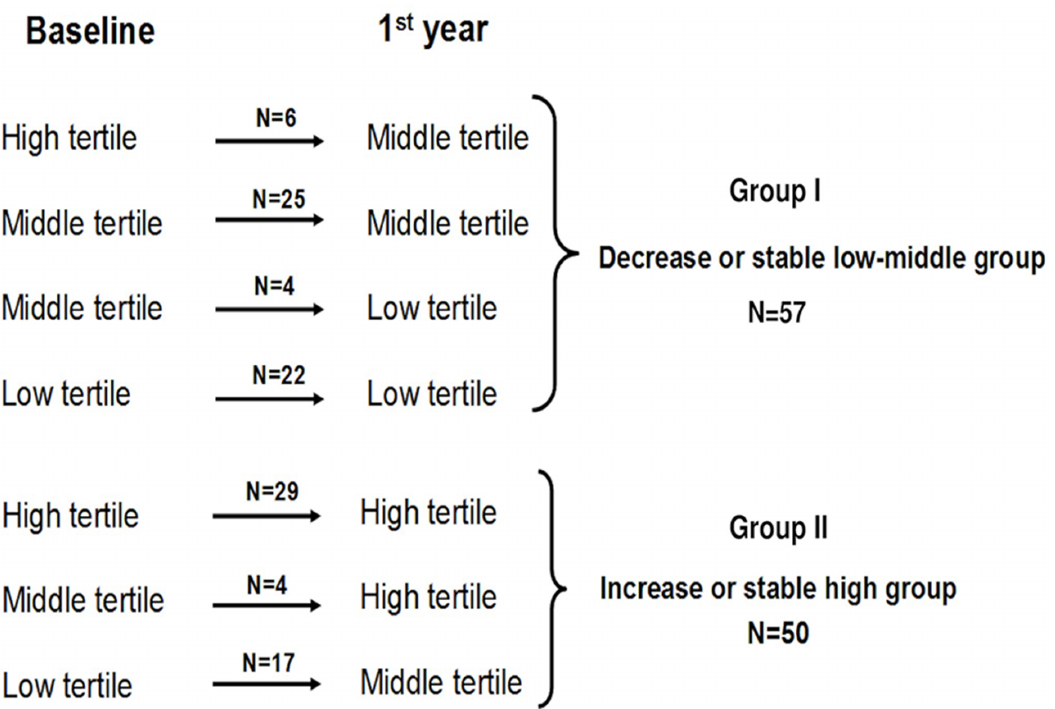
Fig 1. Variation patterns of c-IMT tertiles according to the fluctuation between the c-IMT measurements during study. No patients with a high baseline c-IMT evolved to a low c-IMT tertile at the first year post-transplantation. Similarly, no patients with a low baseline c-IMT tertile evolved to a high c- IMT